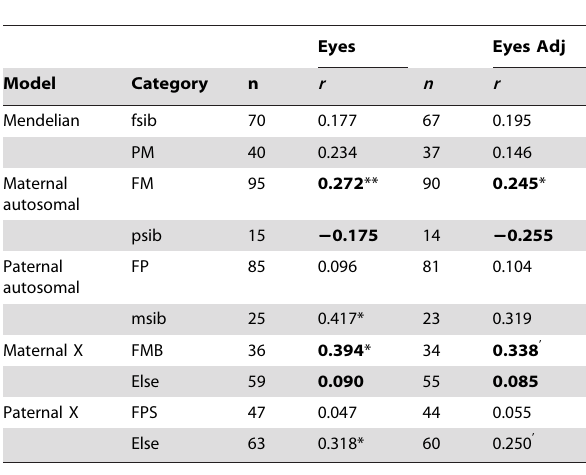
Table 3. Pearson correlations ( r ) between siblings for Eyes scores and Eyes scores adjusted by removing the low-scoring outliers (Eyes Adj . 17).